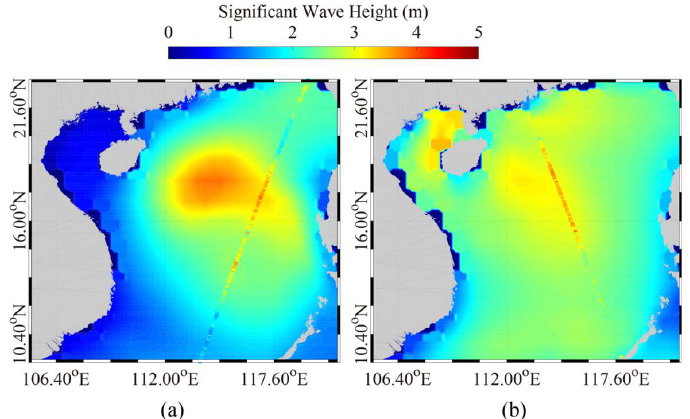
Figure 3. The maps of ECMWF significant wave height (SWH) overlaid with footprints of satellite altimeter Jason-2. ( a ) SWH map on 13 September 2017 at 12:00 p.m. UTC during Typhoon Doksuri; and ( b ) SWH map on 15 October 2017 at 6:00 p.m. UTC during Typhoon